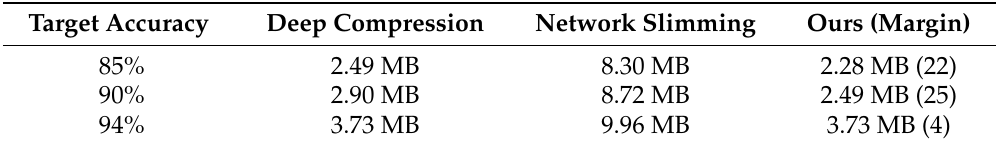
Table 5. The sizes of the minimized models in the corresponding accuracies derived from the proposed method and the individual cases of network slimming and deep compression for DenseNet-121.